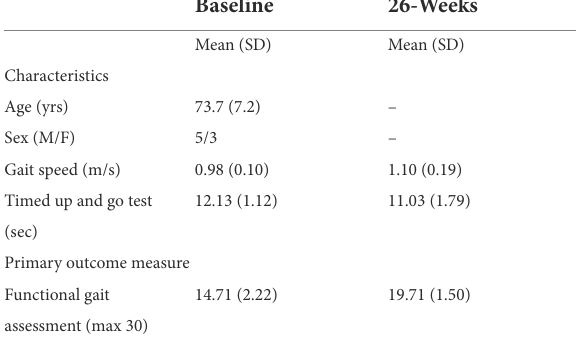
TABLE 1 Participant characteristics ( N =